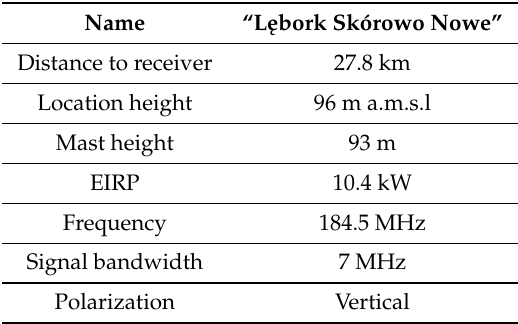
Figure 4. The cooperative aerial target.